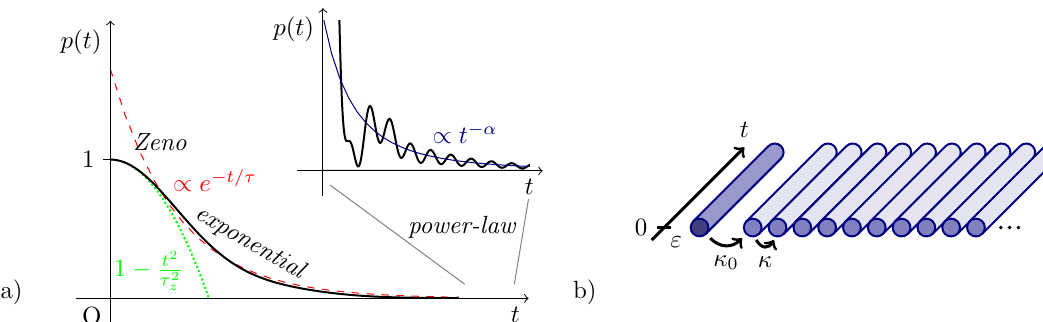
Figure 1. ( a ) Typical temporal evolution of the survival probability p ( t ) of a discrete quantum state coupled to a continuum, where different regimes can be observed at short, intermediate and late evolution times. ( b ) The system is a linear array of optical waveguides, coupled by evanescent-field interaction, excited with coherent light. The first waveguide represents the discrete state and is coupled to the remaining part of the array, which acts as a continuum of states. The temporal evolution of the system is mapped into the longitudinal propagation coordinate t . See the text for